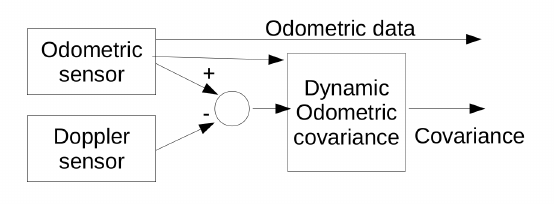
Figure 9. Diagram of the variable covariance change based on Doppler and odometric data